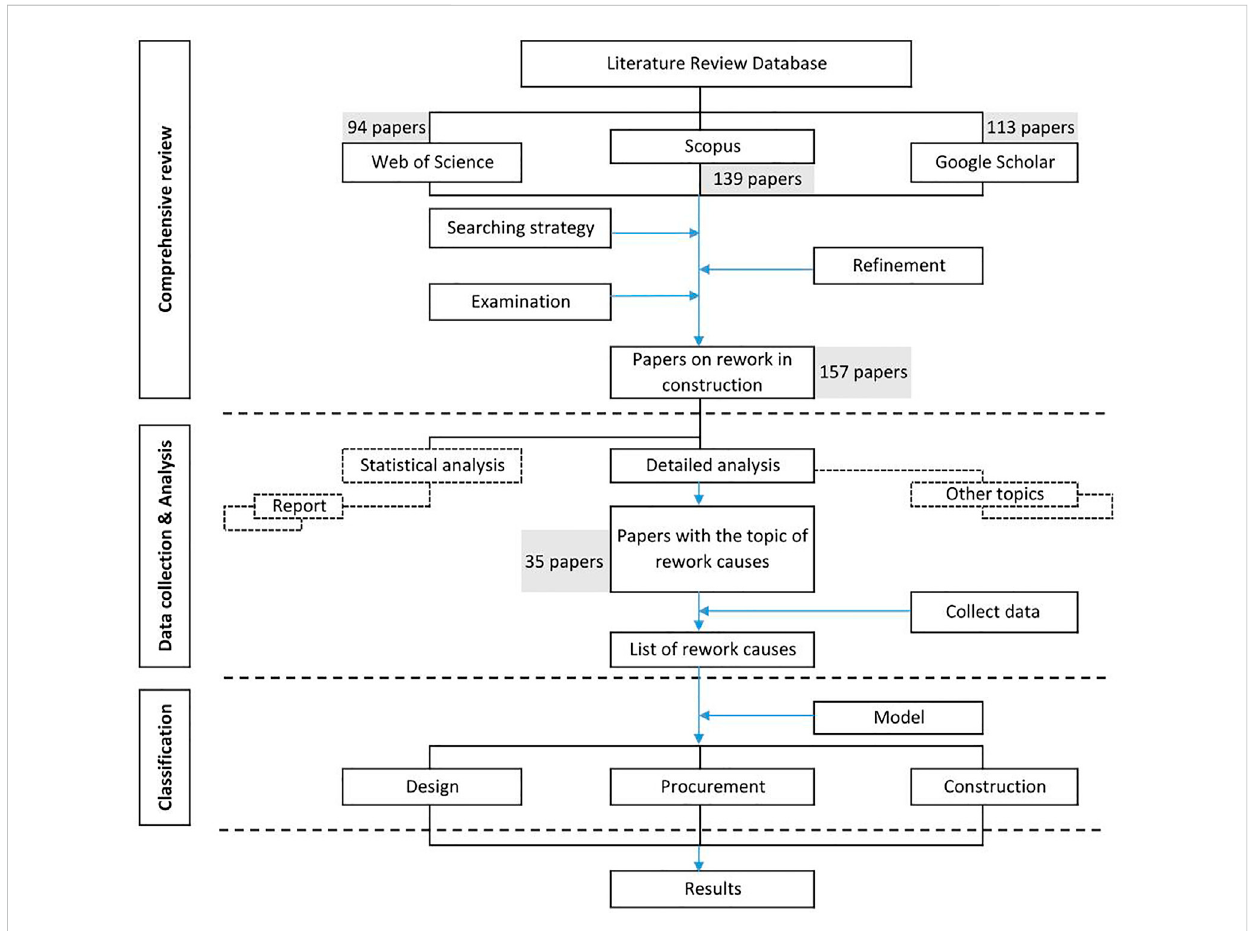
The process of research